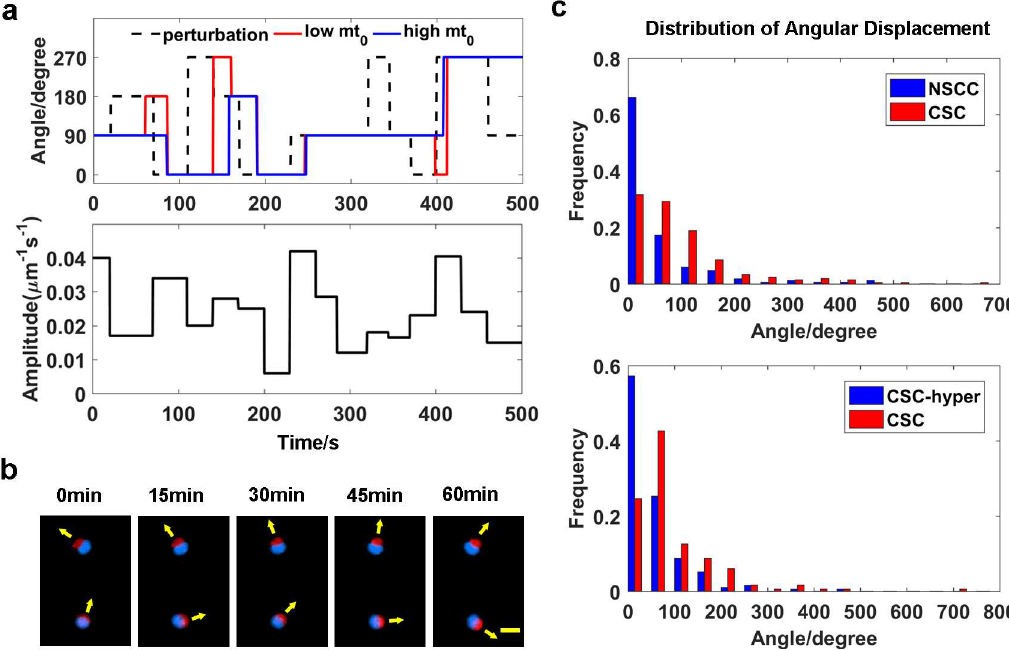
Fig 3. Membrane tension affectsthe dynamics of cell polarity. (a) When the stimulus switches betweenfour directions, i.e., 0, 90, 180, 270, (top, black dashed line) and varies in its amplitude(bottom), higherinitial membrane tension (top, red) improves the stability of the polarizedcell comparedto lower initial membranetension (top, blue). (b) Representative images of the cell polarity dynamics. Scale bar: 20 μ m . (c) Histogramof the angulardisplacement of polarizedCSCs and NSCCs (top), as well as CSCs and